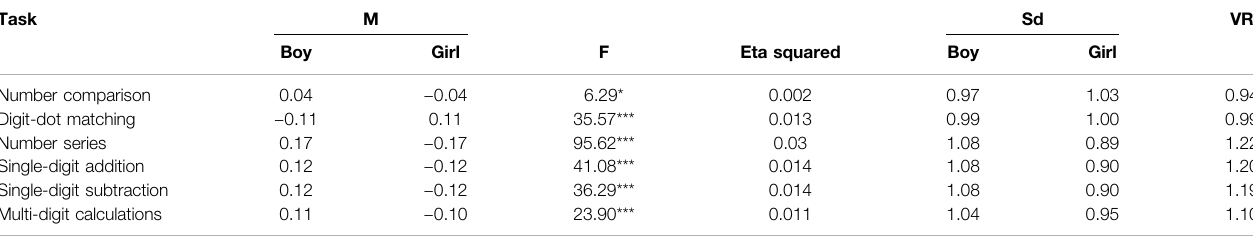
TABLE4 | The standardized means, standard deviations, and variance ratios (VR) in all tasks. Task M Sd Boy Girl F Eta squared Boy Girl Number comparison